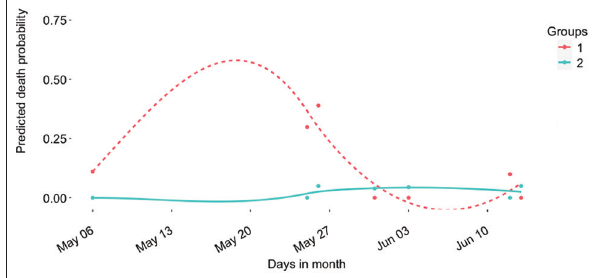
Figure-2: Predicted death probability regressed on days in month. Death incidents were observed in the month of May and June with the highest probabilities (0.10, 0.30, and 0.38) on 6 th , May 25 and 26, respectively. No further deaths occurred beyond June 13. The dotted and continuous lines represent Group 1 and Group 2,